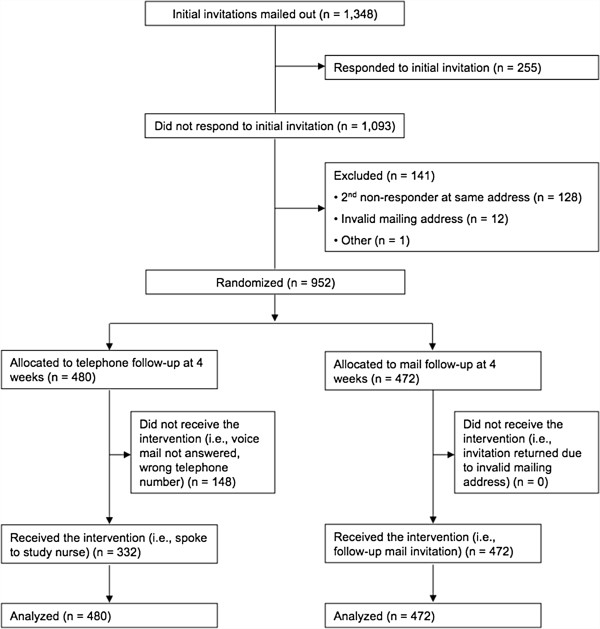
Study flow diagram.